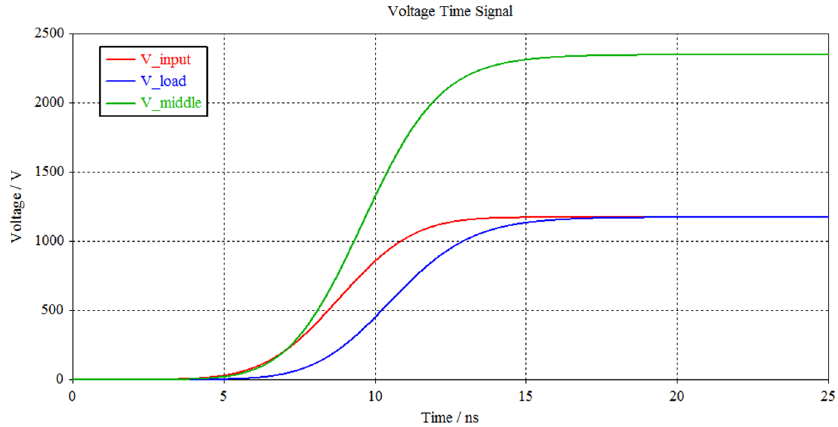
Figure 4. Simulated waveforms propagation: at the input port ( red ), at the output ( blue ) and in the middle of the structure for synchronous excitation with two ports ( green ).